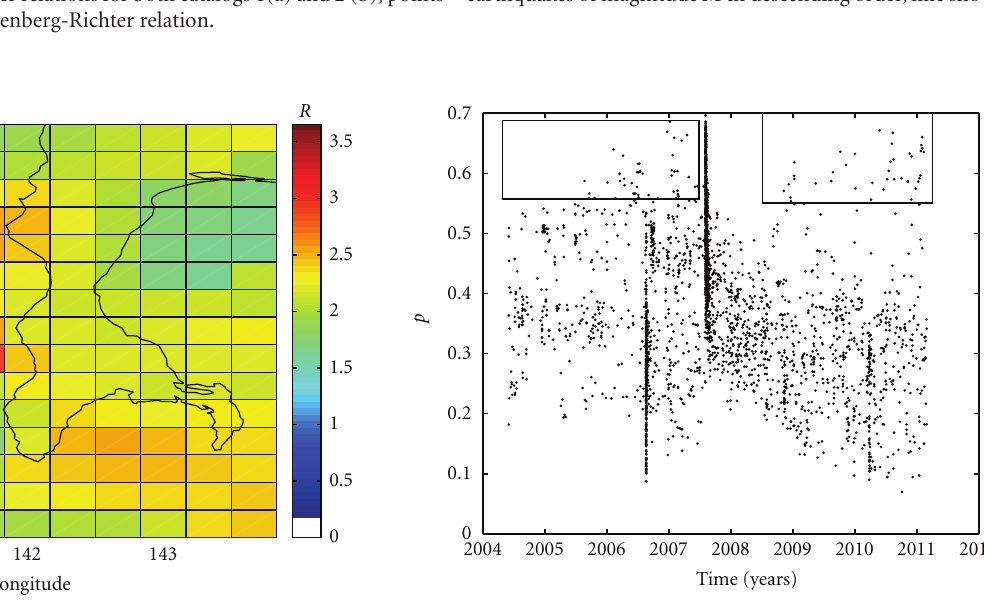
Figure 7: Scheme of changes of the values R ( ϕ , λ ), spatial compo- nent of the SEM model.